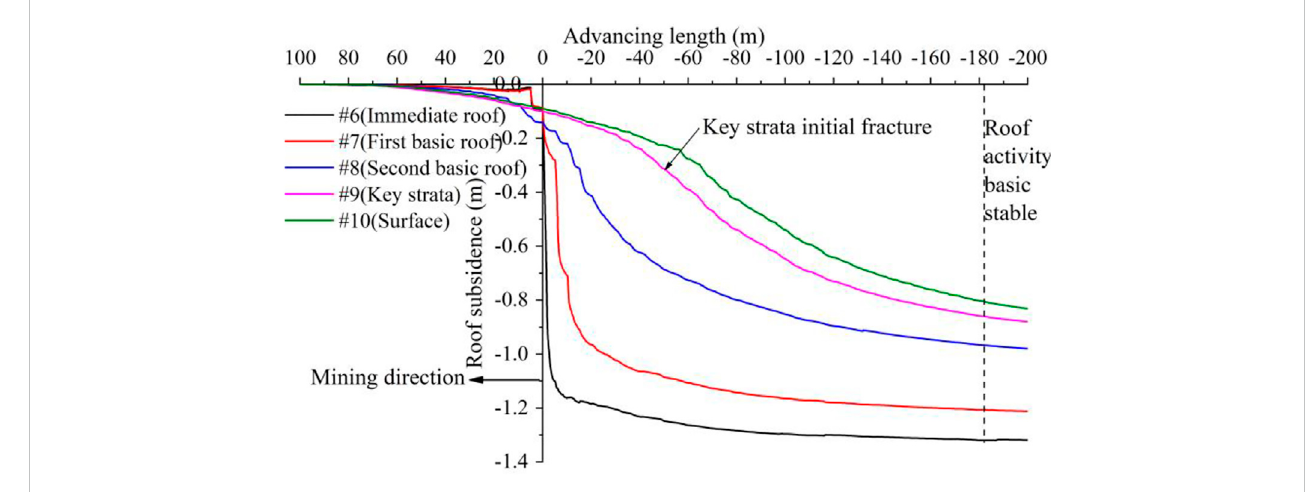
FIGURE 14 Roof subsidence